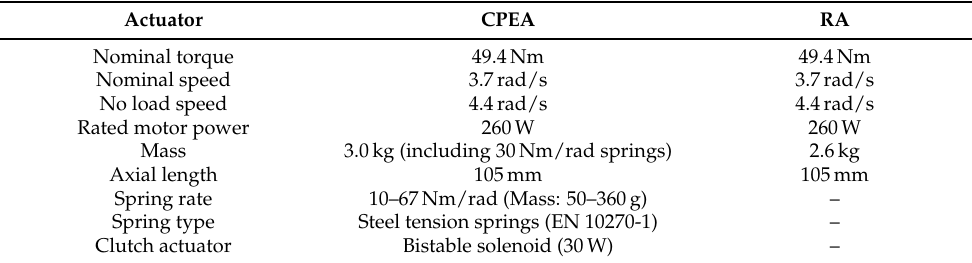
Table 2. Technical data of both